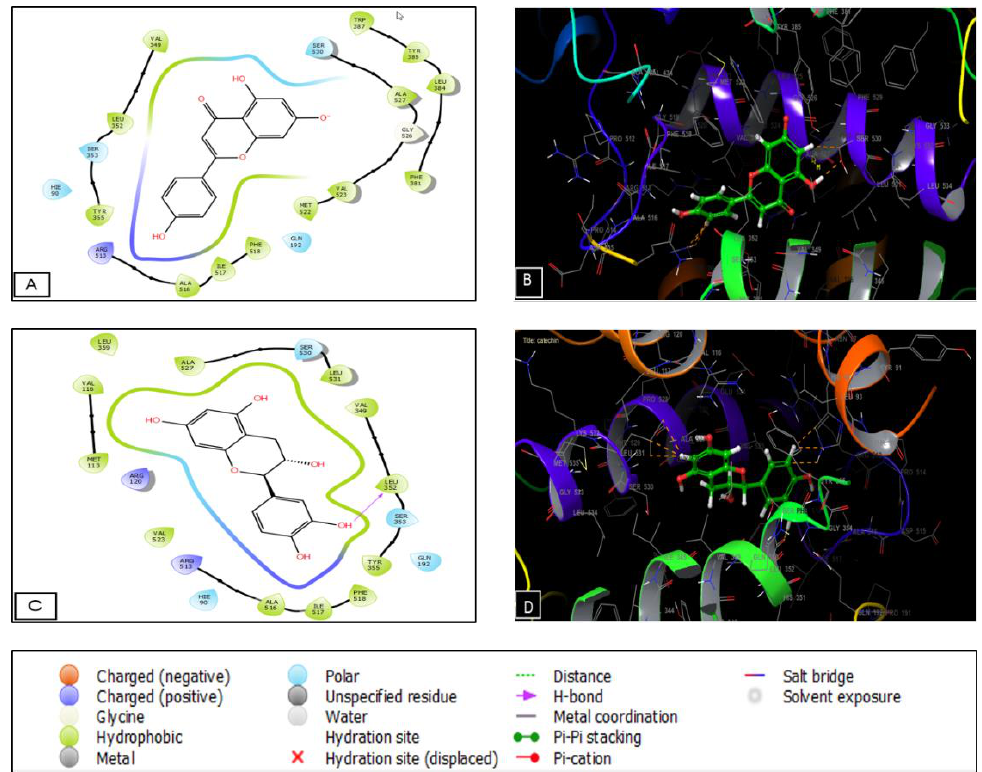
Figure 9. Diagrams showing apigenin ’ s interactions with the cyclooxygenase-2 receptor ’ s active sites are shown in ( A ) 2D and ( B ) 3D. Diagrams of the catechin interactions with the cyclooxygenase-2 receptor ’ s active sites are shown in ( C ) 2D and ( D ) 3D.